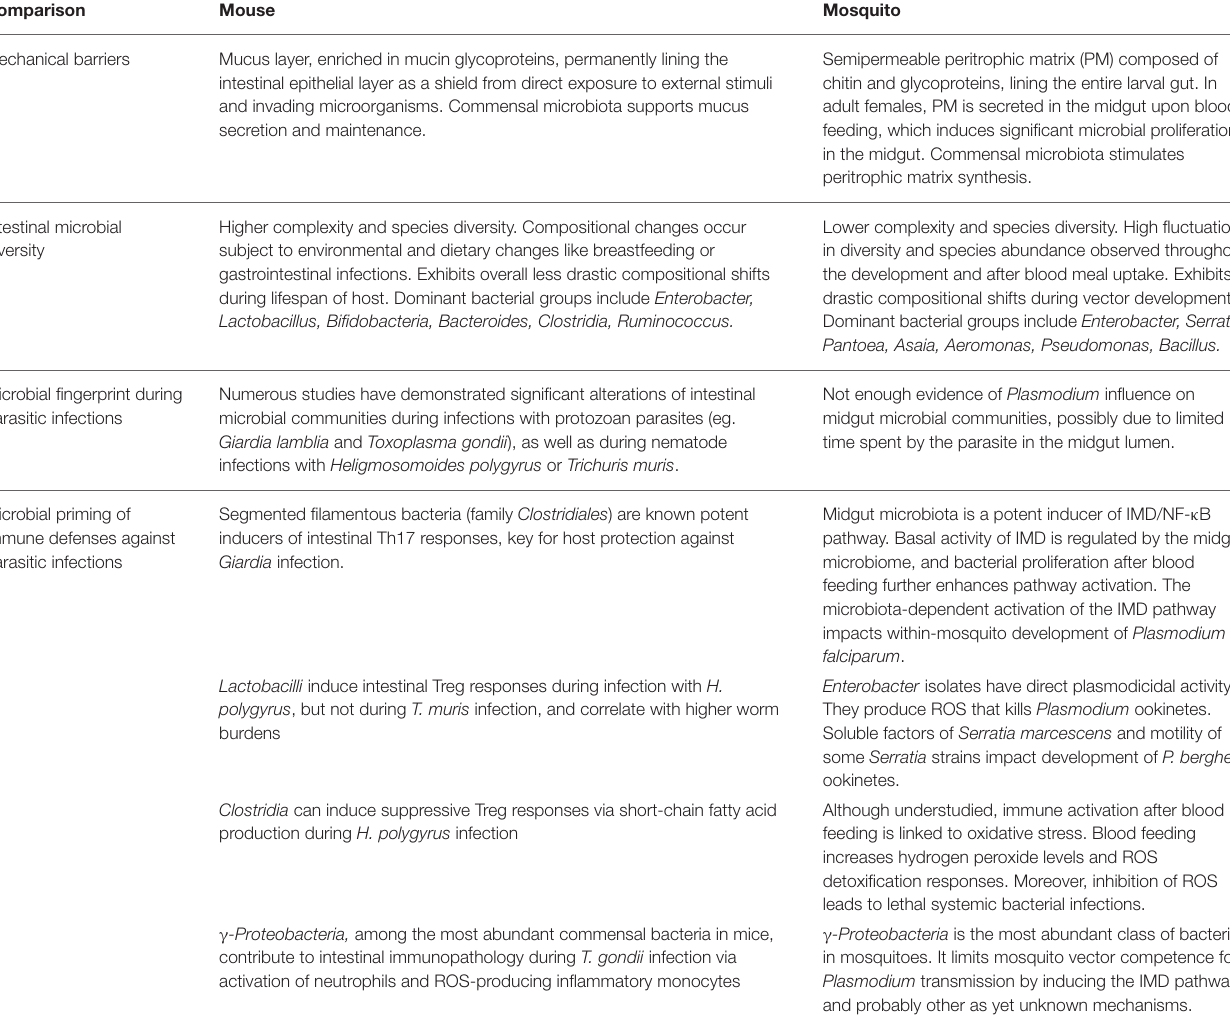
TABLE 2 | Comparison of intestinal immunity, microbial diversity and microbiota-related interactions within the murine hosts and the mosquito vectors during intestinal parasitic infections. Comparison Mouse